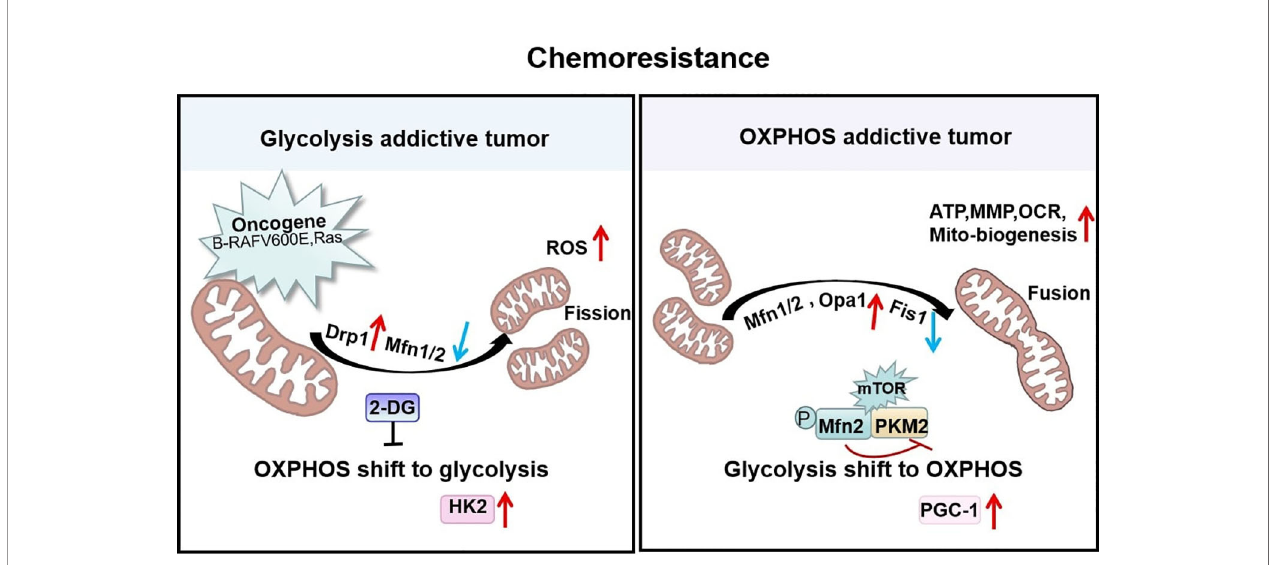
FIGURE 4 | Mitochondrial shaping protein-dependent metabolism and chemoresistance. Tumors addicted to glycolysis exhibit fragmented mitochondria that are predominantly Drp1-dependent with high reactive oxygen species (ROS) levels to enhance chemoresistance. In contrast, tumors addicted to OXPHOS exhibit high Mfn1/2-regulated fused mitochondria possessing elevated ATP, MMP, OCR, and mitochondrial biogenesis to resist